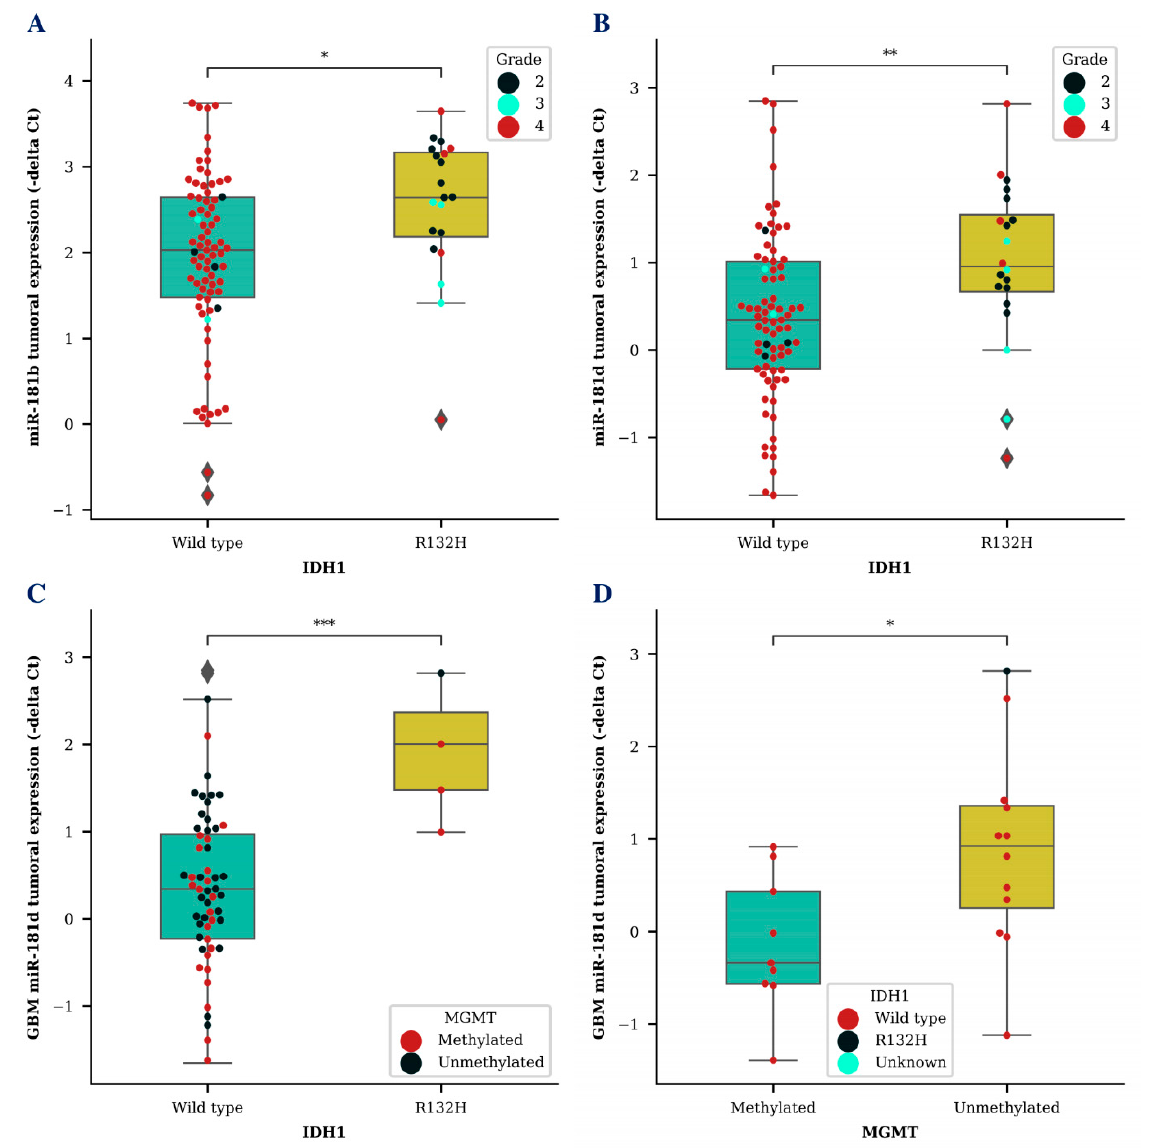
Figure 2. MiR-181b and miR-181d tumoral expression level association with known glioma biomarkers. Tumoral miR-181b ( A ) and miR-181d (B ) expression di ff erences between glioma patients ( A , B ) or GBM patients ( C ) with IDH1 wildtype and IDH1 R132H variant. Tumoral miR-181d levels in GBM patients with methylated MGMT promoter and unmethylated MGMT promoter status ( D ). Colored dots represent di ff erent IDH1 R132H variant ( D ) or MGMT promoter methylation status ( C ) and glioma grade ( A , B ). The box squares represent the data within 25 and 75 percentiles; the line in the middle shows the median.